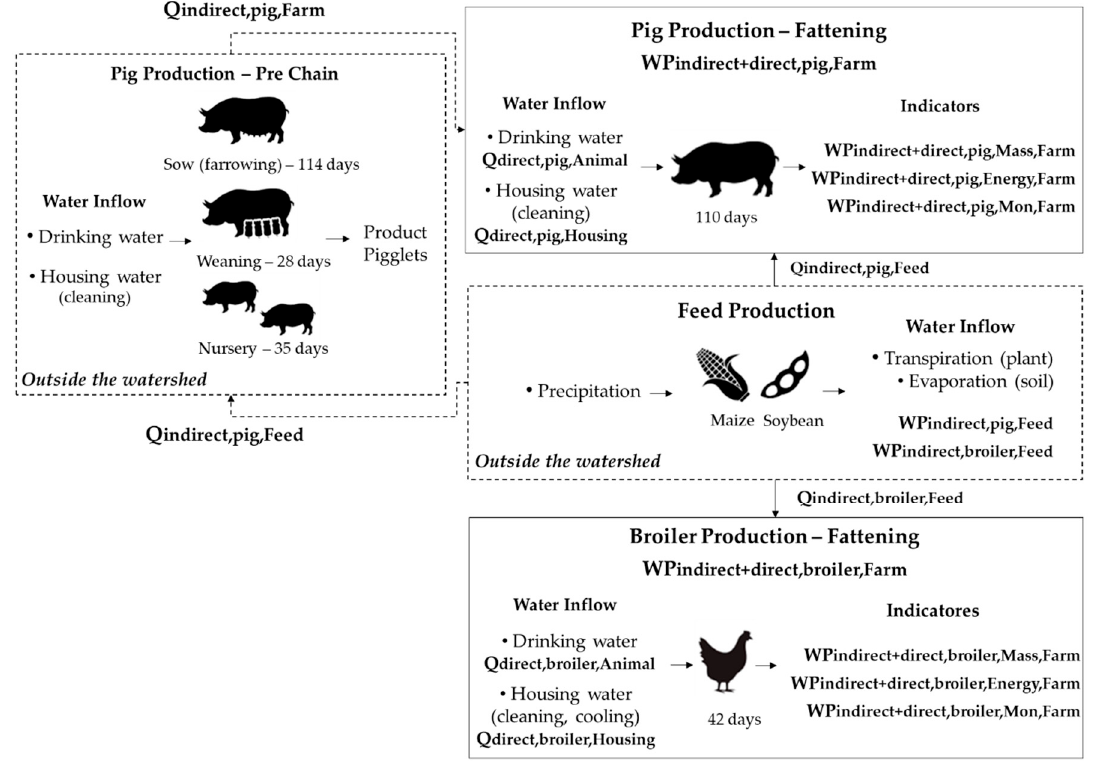
Figure 2. Animal performance indicators and water flows scheme of animal production chain Figure2. Animalperformanceindicatorsandwaterflowsschemeofanimalproductionchainconsidered considered in this study. in this